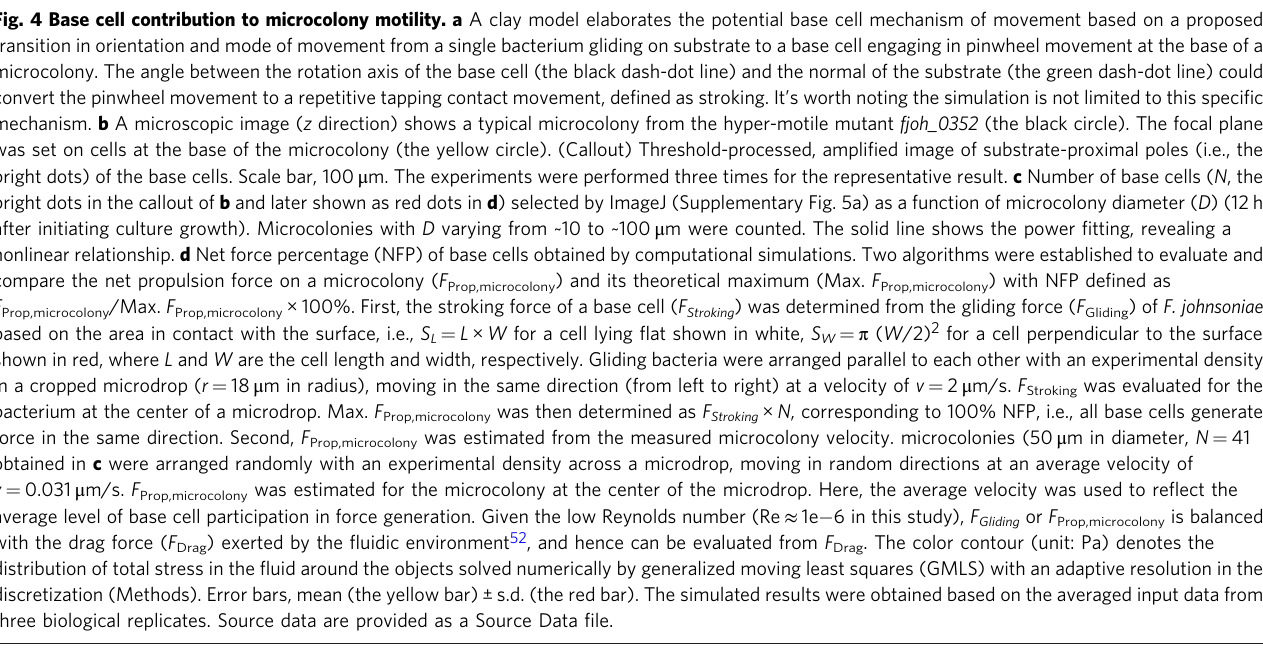
Fig. 4 Base cell contribution to microcolony motility. a A clay model elaborates the potential base cell mechanism of movement based on a proposed transition in orientation and mode of movement from a single bacterium gliding on substrate to a base cell engaging in pinwheel movement at the base of a microcolony. The angle between the rotation axis of the base cell (the black dash-dot line) and the normal of the substrate (the green dash-dot line) could convert the pinwheel movement to a repetitive tapping contact movement, de fi ned as stroking. It ’ s worth noting the simulation is not limited to this speci fi c mechanism. b A microscopic image ( z direction) shows a typical microcolony from the hyper-motile mutant fjoh_0352 (the black circle). The focal plane was set on cells at the base of the microcolony (the yellow circle). (Callout) Threshold-processed, ampli fi ed image of substrate-proximal poles (i.e., the bright dots) of the base cells. Scale bar, 100 μ m. The experiments were performed three times for the representative result. c Number of base cells ( N , the bright dots in the callout of b and later shown as red dots in d ) selected by ImageJ (Supplementary Fig. 5a) as a function of microcolony diameter ( D ) (12 h after initiating culture growth). Microcolonies with D varying from ~10 to ~100 μ m were counted. The solid line shows the power fi tting, revealing a nonlinear relationship. d Net force percentage (NFP) of base cells obtained by computational simulations. Two algorithms were established to evaluate and compare the net propulsion force on a microcolony ( F Prop,microcolony ) and its theoretical maximum (Max. F Prop,microcolony ) with NFP de fi ned as F Prop,microcolony /Max. F Prop,microcolony × 100%. First, the stroking force of a base cell ( F Stroking ) was determined from the gliding force ( F Gliding ) of F. johnsoniae based on the area in contact with the surface, i.e., S L = L × W for a cell lying fl at shown in white, S W = π ( W /2) 2 for a cell perpendicular to the surface shown in red, where L and W are the cell length and width, respectively. Gliding bacteria were arranged parallel to each other with an experimental density in a cropped microdrop ( r = 18 μ m in radius), moving in the same direction (from left to right) at a velocity of v = 2 μ m/s. F Stroking was evaluated for the bacterium at the center of a microdrop. Max. F Prop,microcolony was then determined as F Stroking × N , corresponding to 100% NFP, i.e., all base cells generate force in the same direction. Second, F Prop,microcolony was estimated from the measured microcolony velocity. microcolonies (50 μ m in diameter, N = 41 obtained in c were arranged randomly with an experimental density across a microdrop, moving in random directions at an average velocity of v = 0.031 μ m/s. F Prop,microcolony was estimated for the microcolony at the center of the microdrop. Here, the average velocity was used to re fl ect the average level of base cell participation in force generation. Given the low Reynolds number (Re ≈ 1e − 6 in this study), F Gliding or F Prop,microcolony is balanced with the drag force ( F Drag ) exerted by the fl uidic environment 52 , and hence can be evaluated from F Drag . The color contour (unit: Pa) denotes the distribution of total stress in the fl uid around the objects solved numerically by generalized moving least squares (GMLS) with an adaptive resolution in the discretization (Methods). Error bars, mean (the yellow bar) ± s.d. (the red bar). The simulated results were obtained based on the averaged input data from three biological replicates. Source data are provided as a Source Data fi